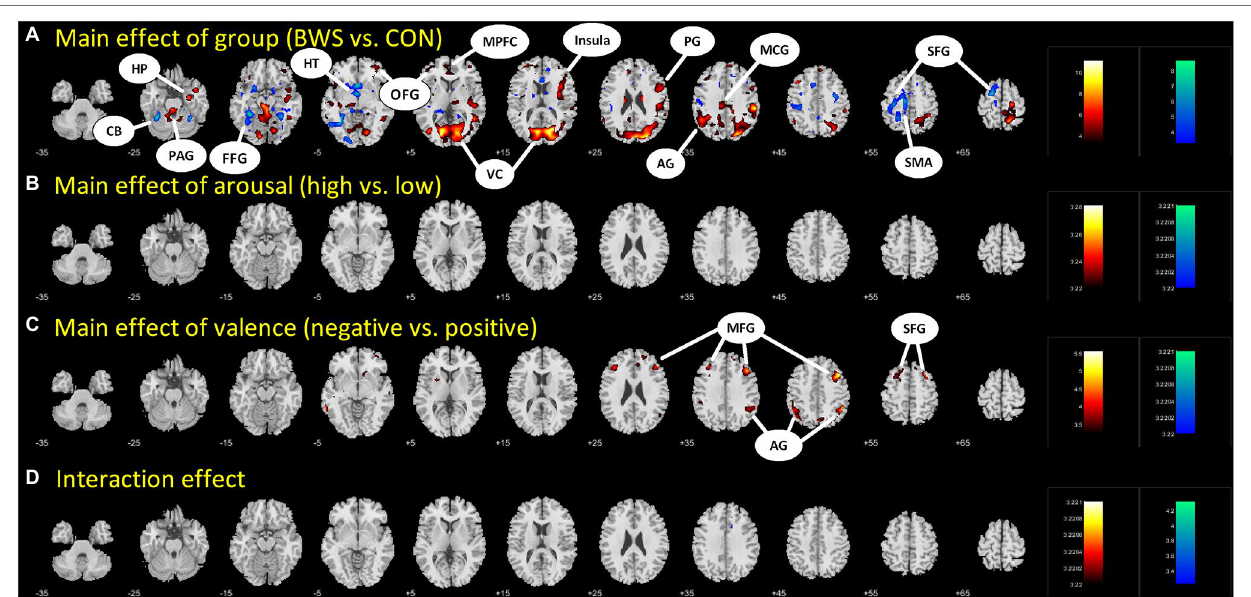
FIGURE 1 | Difference in brain region activations between (A) BWS and CON participant groups across all image presentations, (B) arousal levels of the images (High vs. Low), (C) valence of the presented images (negative vs. Positive), and (D) interaction effects. CB, Cerebellum; HP, Hippocampus; PAG, Periaqueductal gray; FFG, Fusiform gyrus; HT, hypothalamus; OFG, Orbitofrontal gyrus; MPFC, Medial prefrontal cortex; VC, Visual cortex; PG, Precentral gyrus; AG, Angular gyrus; MCG, Middle cingulate gyrus; SFG, Superior frontal gyrus; SMA, Supplementary motor area; and MFG, Middle frontal